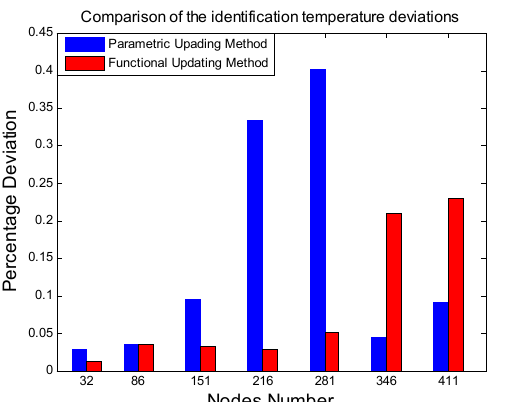
Figure 6. Comparison of identification temperature deviations based on the two methods.